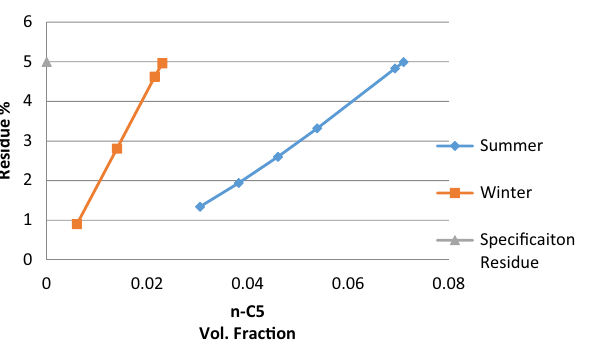
Fig. 23 Effect of adding n-C5 on LPG price